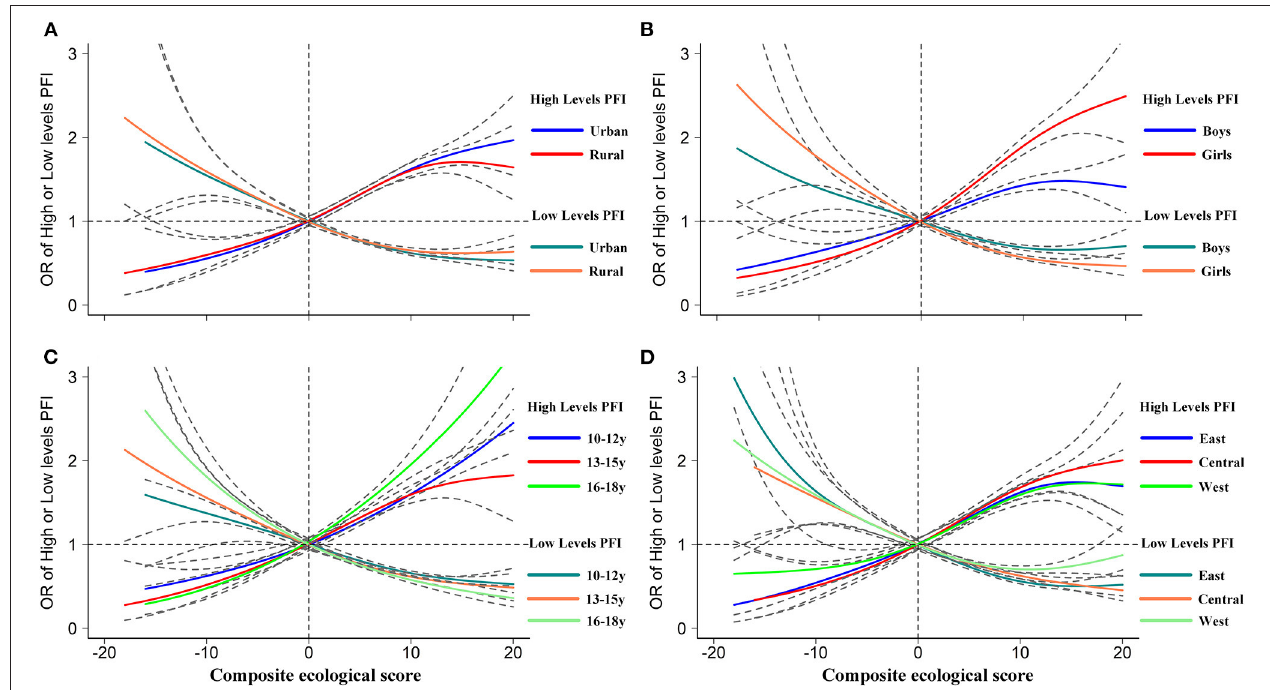
FIGURE 3 | Subgroups analyses of the association between scores of ecological correlates and proportions of low- or high-PFI levels. (A) Areas. (B) Genders. (C) Age groups. (D) Regions. Dotted gray lines indicate 95% CIs. Generalized additive models were used to calculate the non-linear fitting curve of the OR values of high- or low-PFI levels (dependent outcome variables) with the scores of ecological correlates (as independent variables based on median scores of